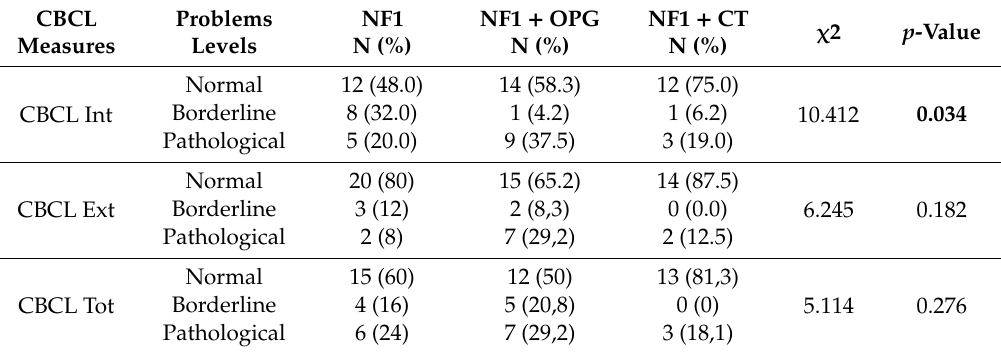
Table 2. Psychopathological ranges distribution among the three